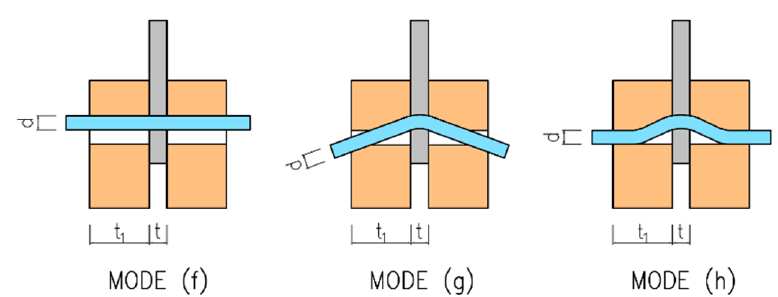
Figure 2. Failure modes for steel-to-timber connections with slotted-in steel plate. The first term on the right-hand side in the above expressions represents the load- carrying capacity according to Johansen’s EYM (ductile failure modes). The failure mode (f) refers to the embedment in the timber element (typical for fasteners of low slenderness). The failure mode (g) corresponds to the embedment in the timber element together with the formation of one plastic hinge in the fastener. The failure mode (h) corresponds to the embedment in the timber element together with the formation of two plastic hinges in the fastener (typical for flexible fasteners of high slenderness). The slenderness ratio between the thickness of the embedded timber element and the diameter of the fastener t 1 /d has a huge influence on the failure mode (see Figure 3). The second term on the right-hand side in the above expressions represents the contribution from the rope effect [42], which should be limited to 25% of the Johansen part for bolts. If the contribution from the rope effect is not known, then it should be taken as zero.